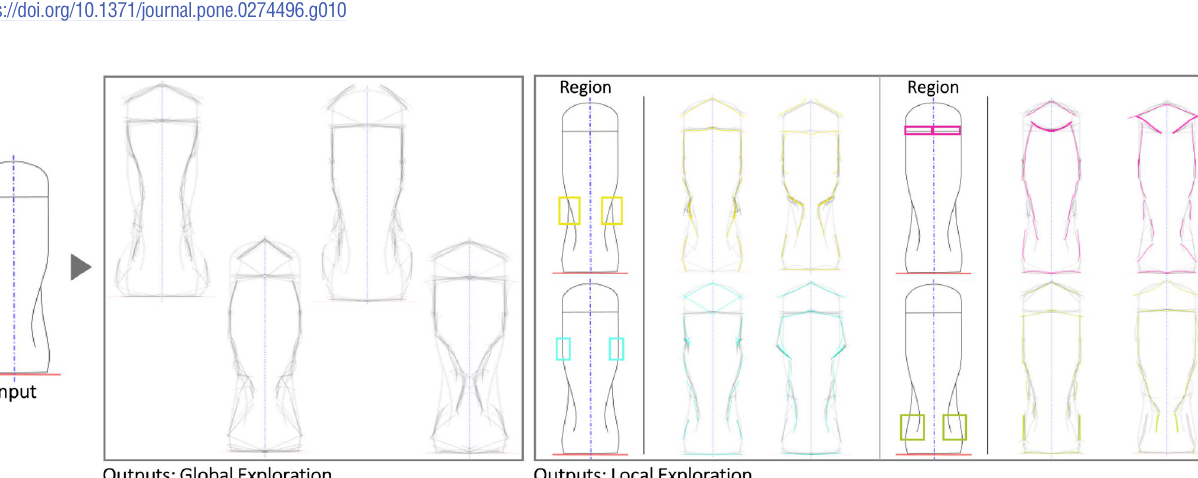
PLOS ONE | https://doi.org/10.1371/journal.pone.0274496 September 12, 2022 19 /